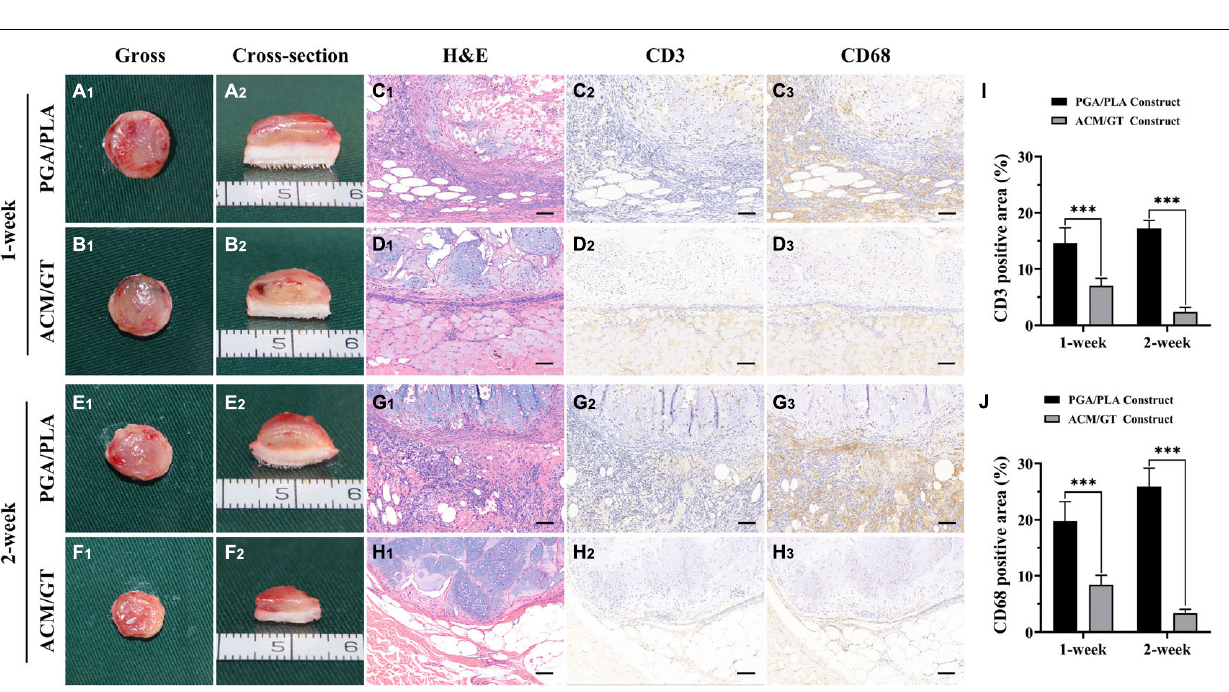
Frontiers in Bioengineering and Biotechnology |